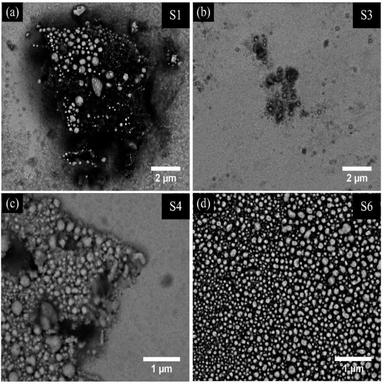
SEM images in the backscattered mode for S1, S3, S4, and S6, revealing the presence of Cu-NPs (the brightest regions).